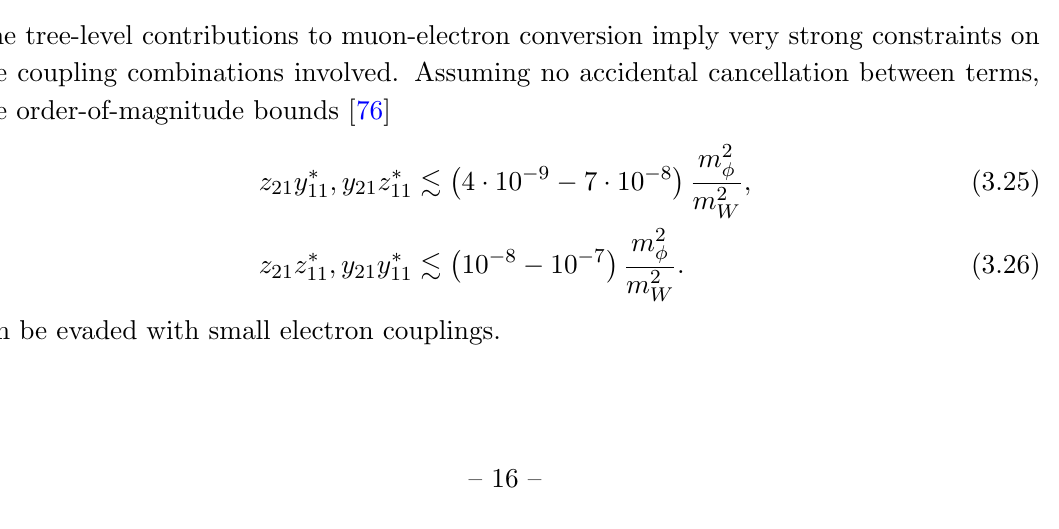
against R (cid:22)=e (top) and R e=(cid:22) (bottom) K D D (cid:3)